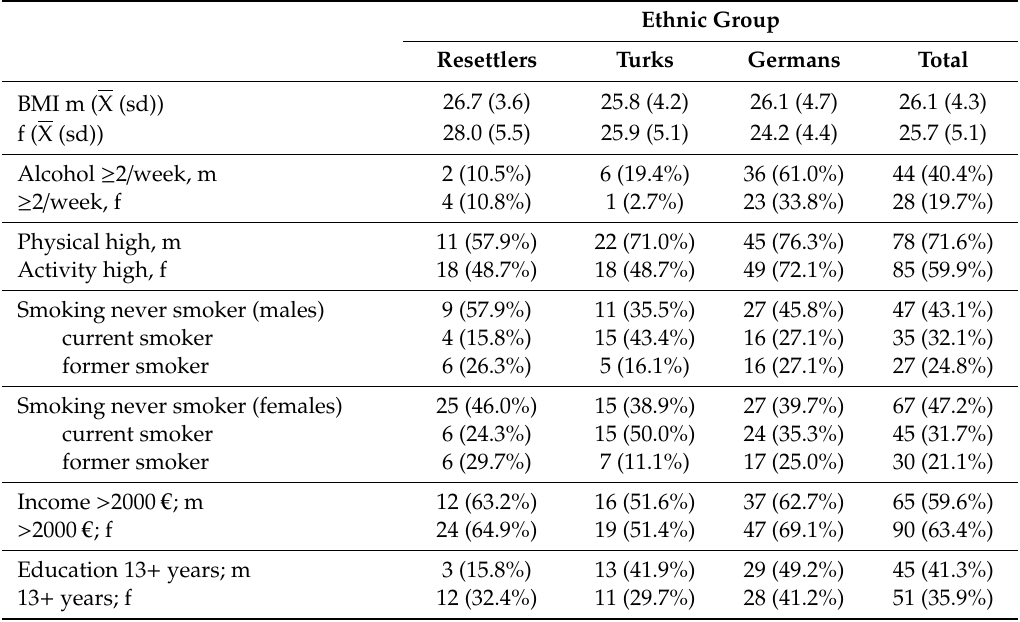
Table A1. Distribution of main variables by ethnic group and